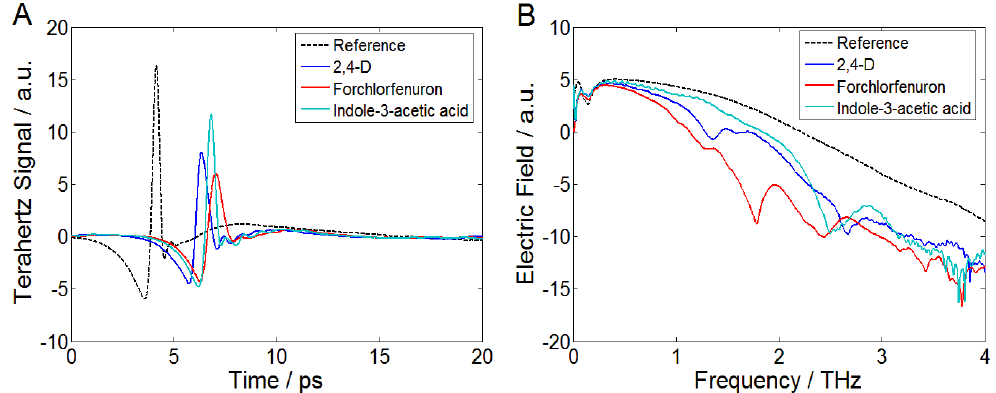
Figure 1. THz spectra of the reference and PGRs. ( A ) Time-domain spectra; ( B ) Frequency-domain spectra.